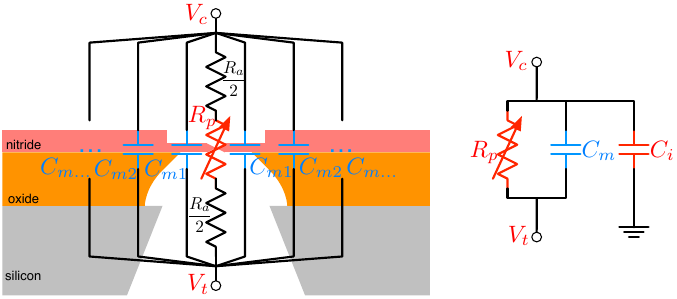
Figure 8. Electric circuit mode of the nanopore with applied voltages V c and V t at the cis and trans